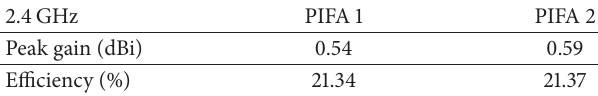
Table 1: Measured peak gain and radiation efficiency. 2.4 GHz